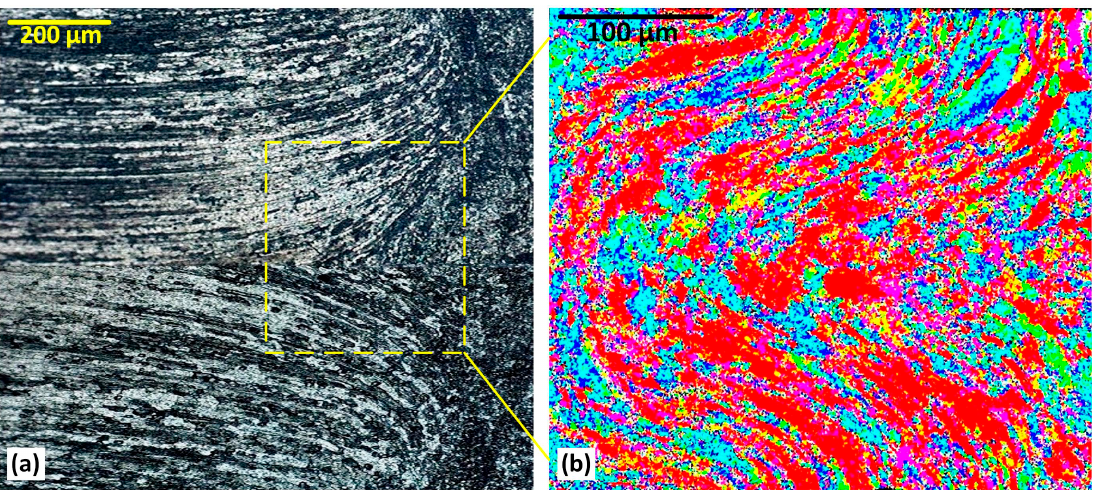
Figure 8. The microstructure of the AS Hourglass border, ( a ) Optical microscopy and ( b ) EBSD colour map.